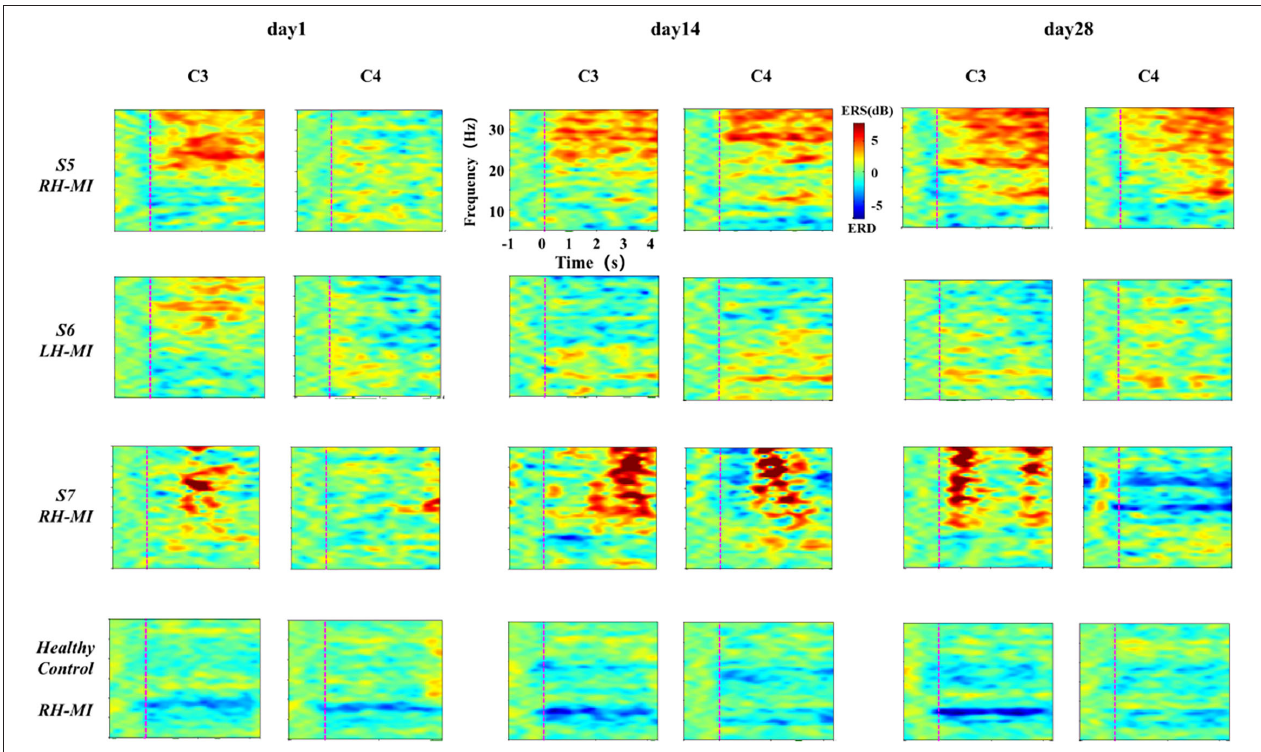
FIGURE 6 | The results of EEG time-frequency response under standard assessment session in control group during long-term rehabilitation